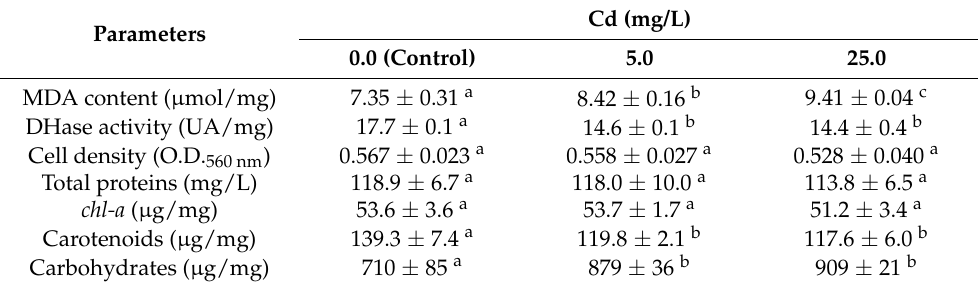
Table 2. Dehydrogenase activity; and concentrations of malondialdehyde (MDA), total protein, photosynthetic pigments, and soluble carbohydrates in Oscillatoria sp. cells after 24-h Cd exposure. Cd Parameters